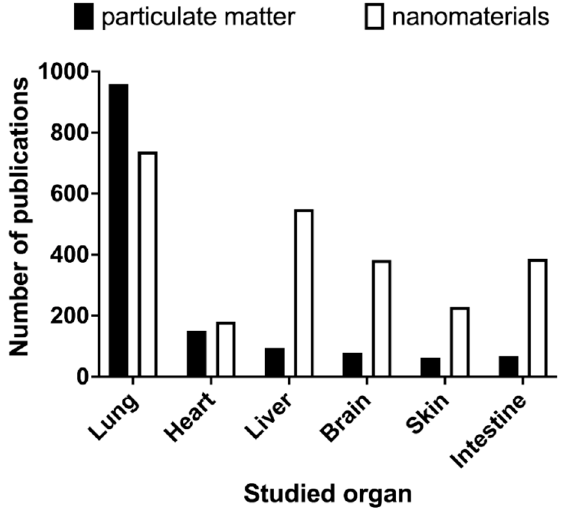
Figure 2. The main target organs studied in the context of (nano)toxicology. A PubMed search for “particulate matter toxicology” or “nanomaterial toxicology” followed by the organ identified on the X-axis was performed in April 2022. No other filters were applied. Of note, using the words “pulmonary”, “cardiovascular”, and “gastrointestinal” instead of the specific organ yields even higher numbers for the 3 categories, but lung-related toxicology still prevails by